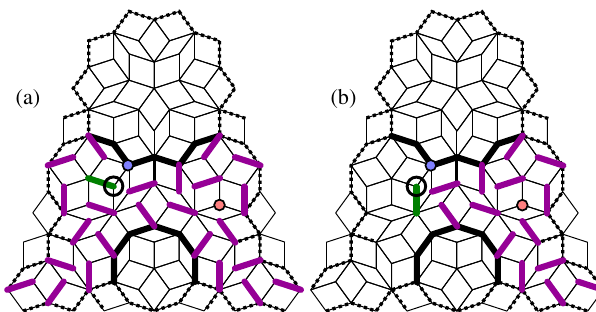
FIG. 20. Proof no monomer can be based on a 5 appearing between a 4-vertex and a 6-vertex in a maximum matching. See accompanying text in Appendix A